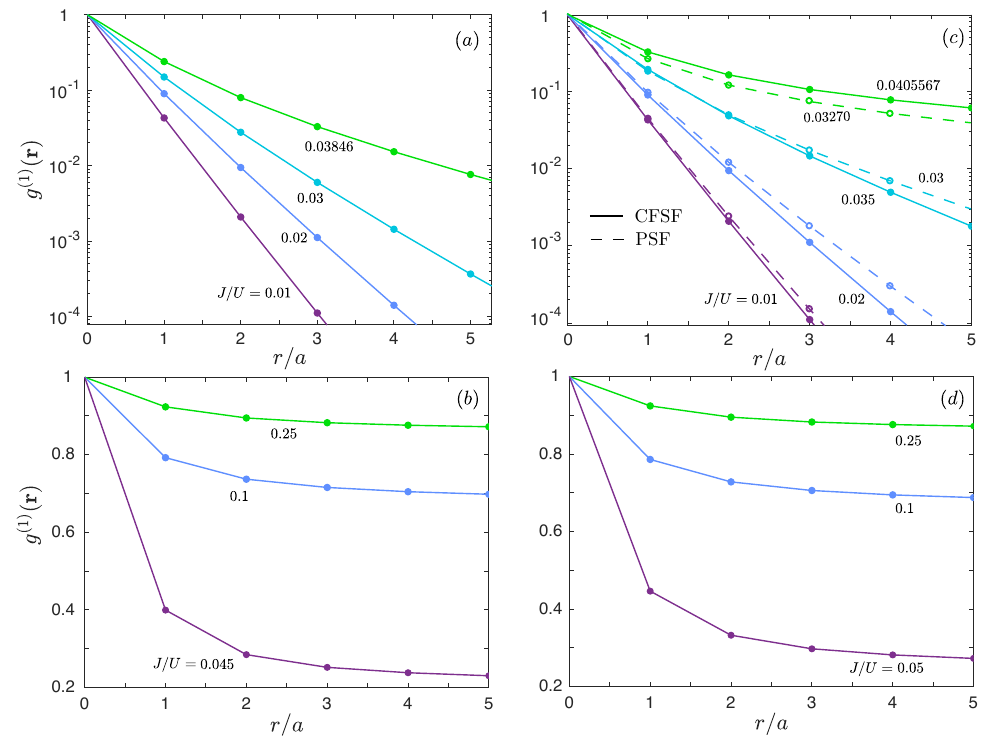
/ U = 0.9 evaluated 12 = − 0.35 and U / U = − 12 c